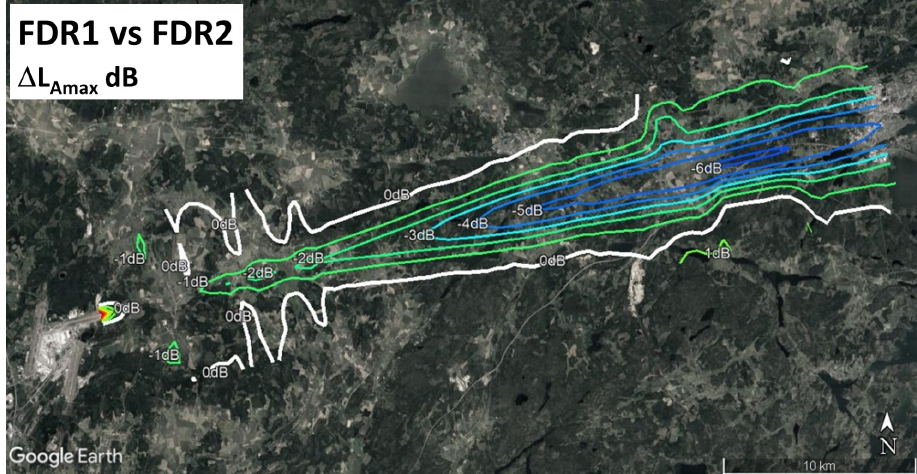
Figure 12. Noise prediction difference of FDR1 with respect to FDR2 using SAFT ECAC Doc 29 implementation.